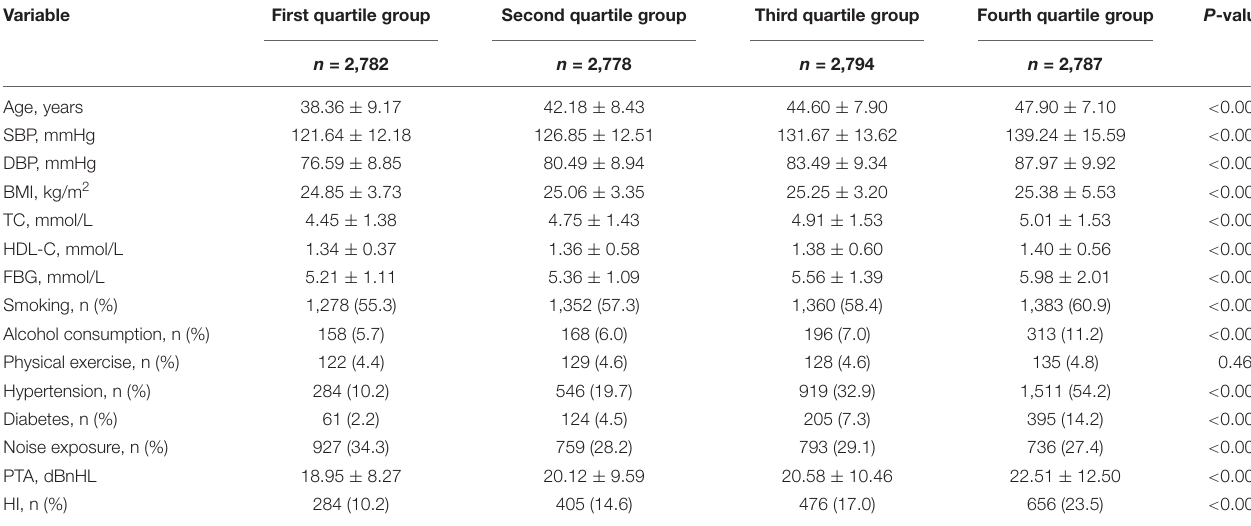
TABLE 1 | Comparison of physical examination data, PTA, and HI detection rates for each baPWV quartile group. Variable First quartile